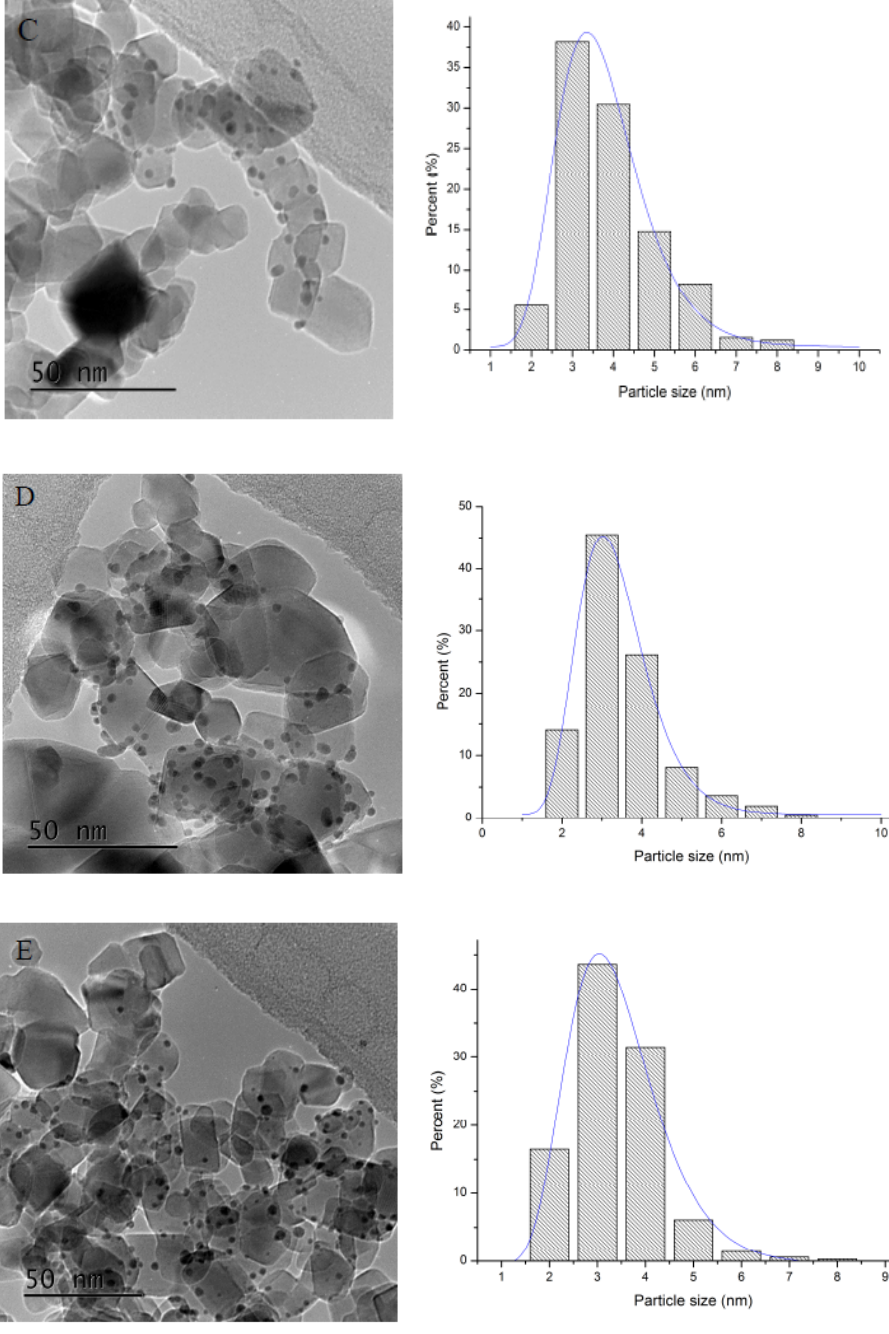
Figure 6. Bright field TEM micrographs and corresponding histograms of the particle size distributions of the catalysts. ( A ): Pd/TiO 2 , ( B ): Au 1 Pd 3 /TiO 2 ( C ): Au 1 Pd 1 /TiO 2 ( D ): Au 3 Pd 1 /TiO 2 and ( E ): Au/TiO 2 .